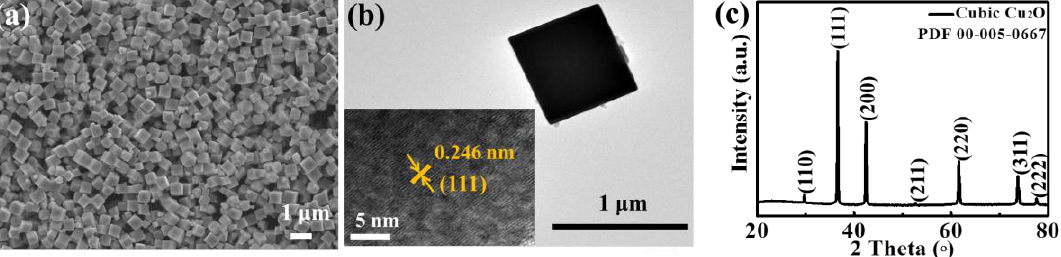
Figure 2. Characterization of p-type Cu 2 O sensing material: ( a ) SEM, ( b ) TEM and HRTEM (inset), and ( c ) XRD pattern.